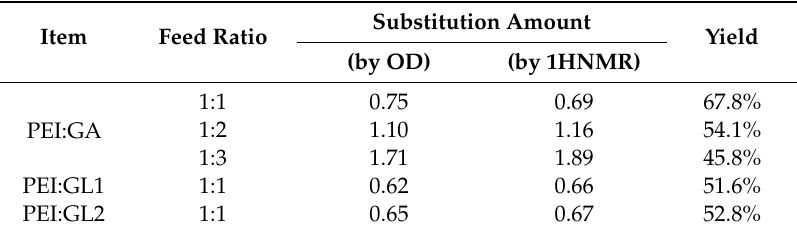
Figure 1. Characterization of and glycyrrhetinic acid (GA) or glycyrrhizin acid (GL) modified PEIs. ( A ) 1H-NMR of polyethyleneimine (PEI)-GA 1.7 , ( B ) PEI-GL2 0.65 . ( C ) UV absorbance of PEI-GA 0.75 (0.1 mg / mL), PEI-GL1 0.62 (0.15 mg / mL) and PEI1.8K (0.384 mg / mL). Table 1. Amount substitution of PEI-GA and PEI-GL.